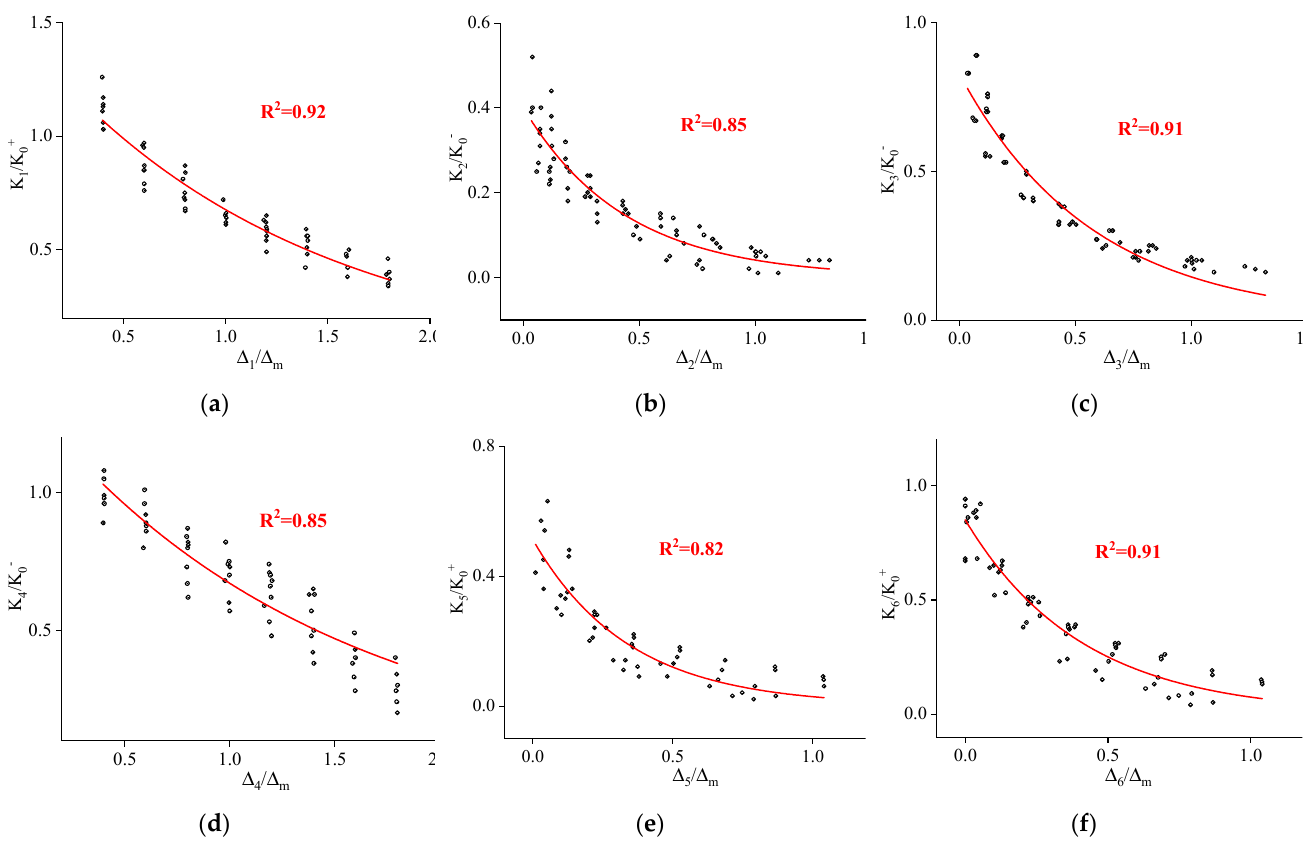
Figure 15. Regression analyses of stiffness-degradation curves: ( a ) K 1 /K 0+ ; ( b ) K 2 /K 0 − ; ( c ) K 3 /K 0 − ; ( d ) K 4 /K 0 − ; ( e ) K 5 /K 0+ ; ( f ) K 6 /K 0+ . Table 5. The regression equation for each degradation stage.